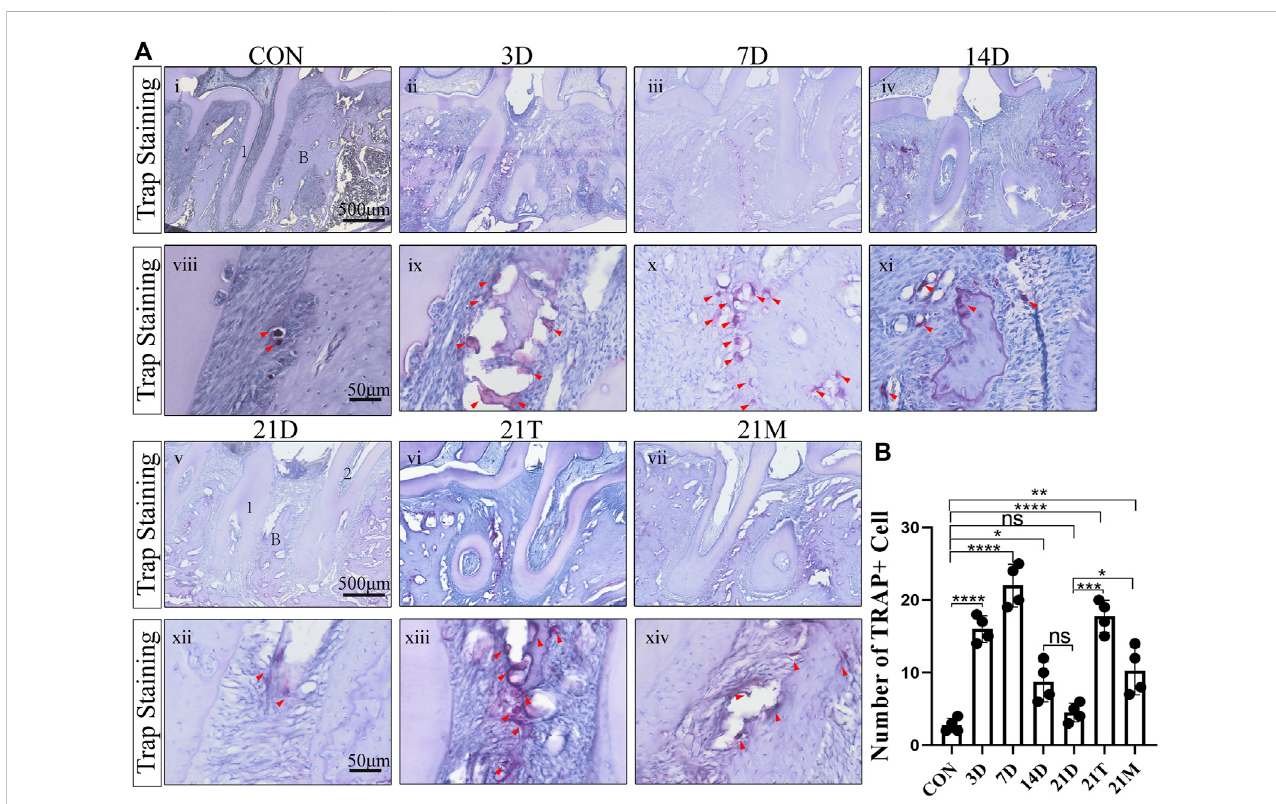
FIGURE 3 The degree of osteoclast in fi ltration (A) Representative TRAP-stained sections of periodontal tissues harvested from each group at low (i-vii) and high (viii-xiv) magni fi cations. 1, the root of the fi rst molar; 2, the root of the second molar; B, alveolar bone. Arrowheads mark osteoclasts. (B) Total osteoclast number between the fi rst and the second molars. Results are the mean ± s.d. (n = 4 rat per group). p < 0.05, ** p < 0.01, *** p < 0.001, **** p < 0.0001, ns no signi fi cance (one-way ANOVA and Bonferroni ’ s post hoc